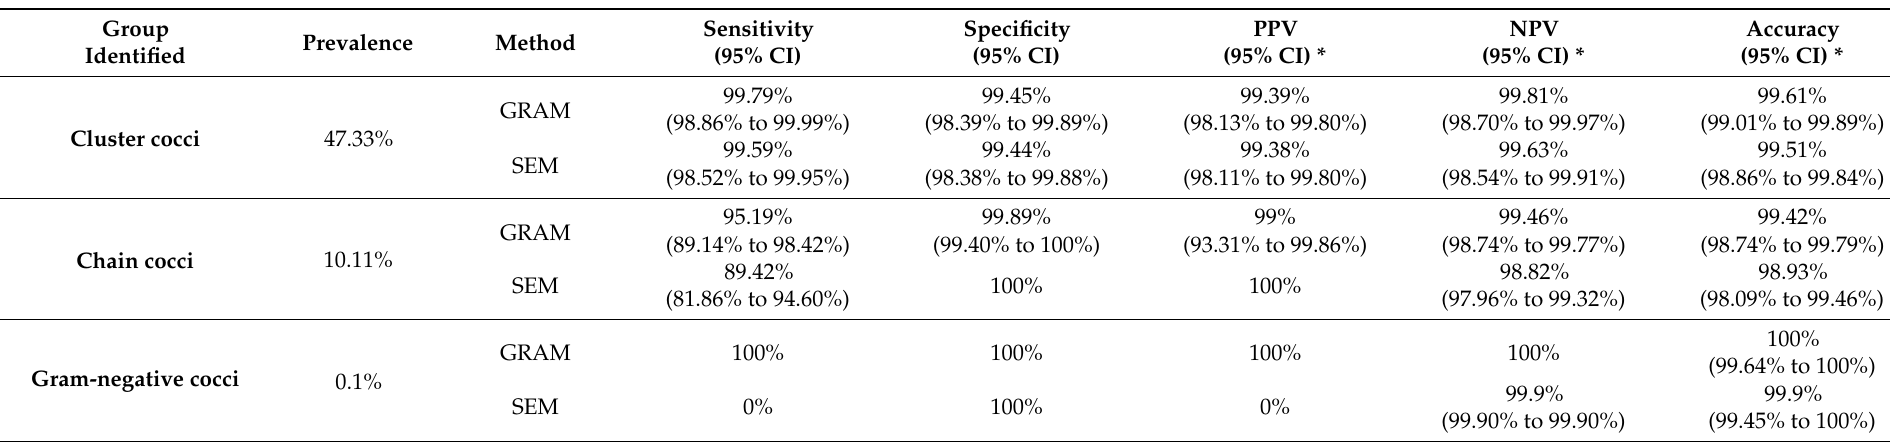
Table 1. Performance characteristics for cocci-shaped bacterial identification using SEM vs. Gram staining with culture-based MALDI-TOF/MS identification as a reference. Group